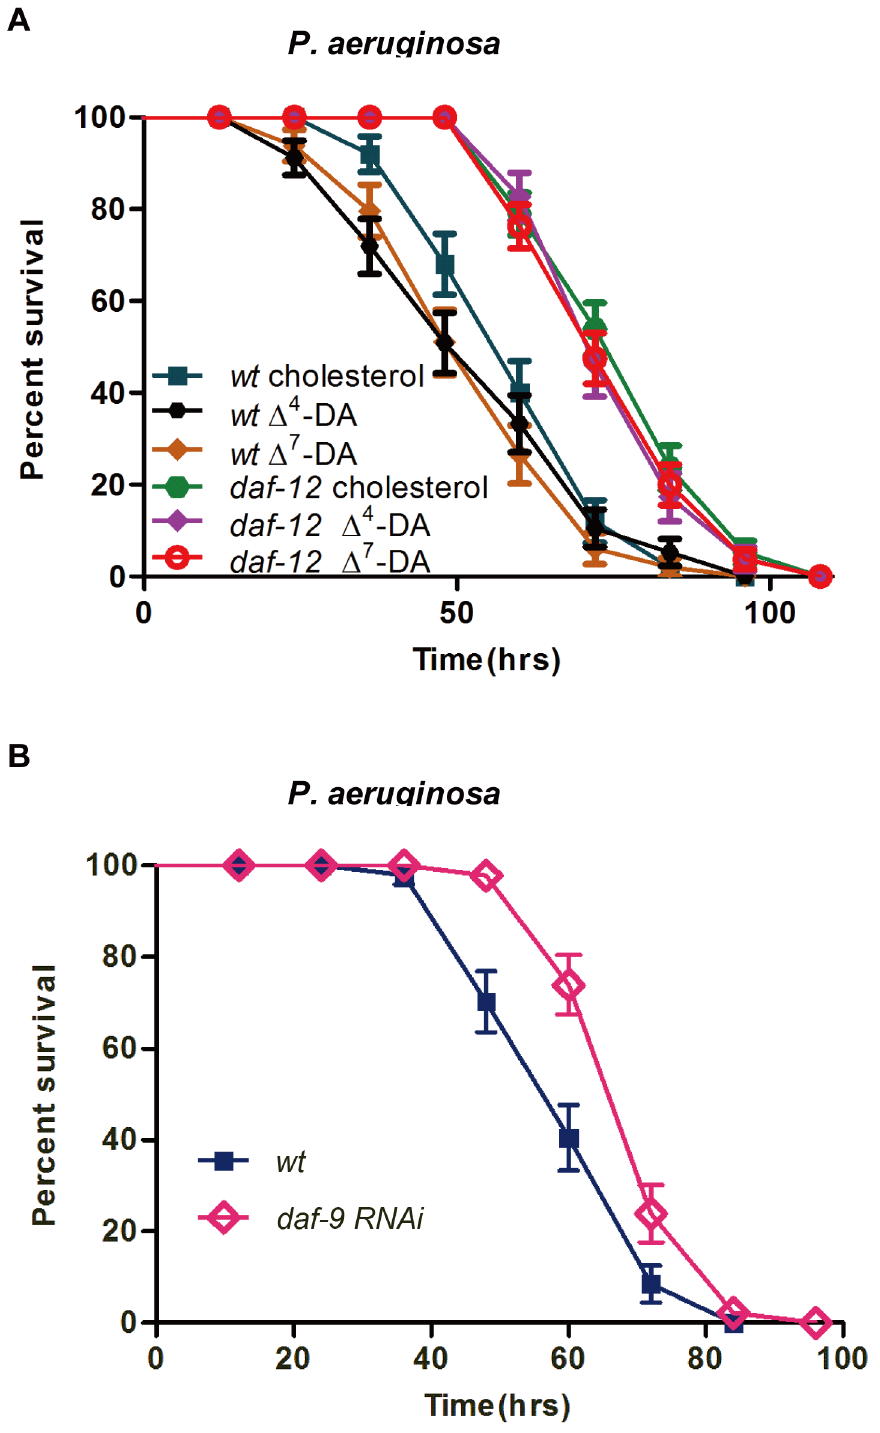
Figure 3. Dafachronic acids (DAs) regulate pathogenic defense through DAF-12. ( A ) P. aeruginosa killing of N2 and daf-12(sa156) worms grown with cholesterol (400 nM), D 4 -DAs (400 nM) ( P =0.2845 and 0.4552, respectively) and D 7 -DAs (400 nM) ( P =0.0426 and 0.5508, respectively). ( B ) P. aeruginosa killing assay of daf-9 RNAi (P , 0.001) animals. All data shown are representative of at least three independent experiments (n $ 50 adult nematodes per strain).